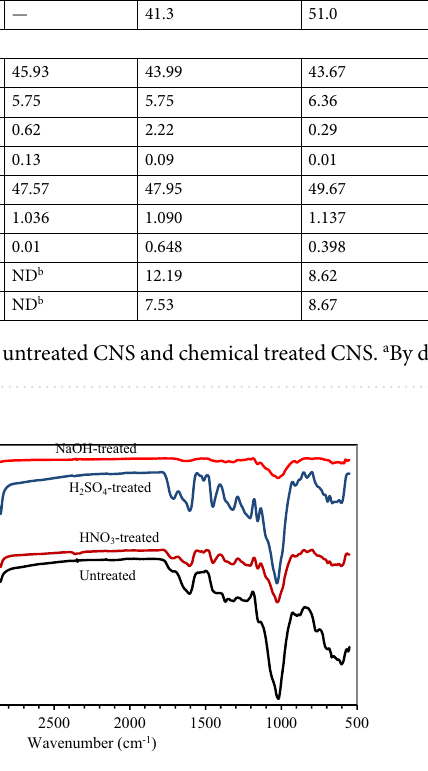
Figure 1. FTIR spectra of untreated and chemical (H 2 SO 4 , HNO 3 or NaOH)-treated